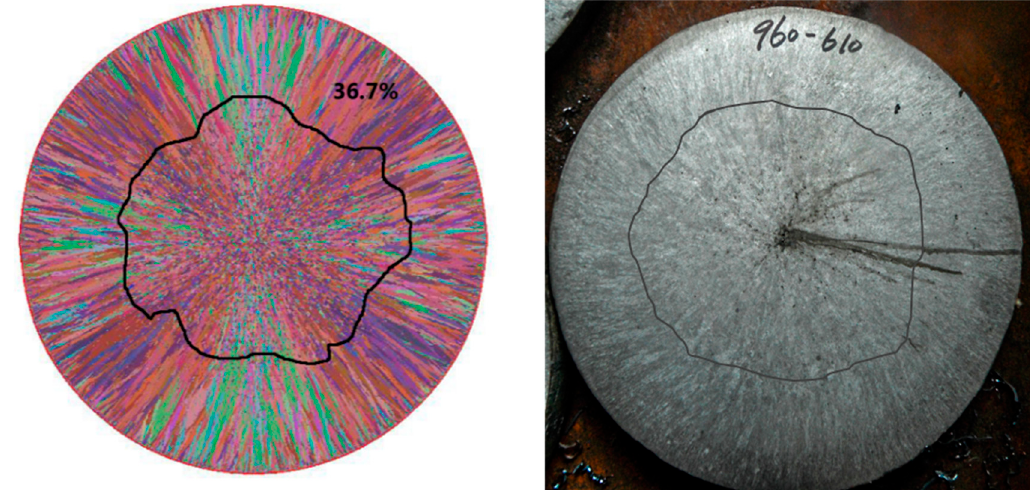
Figure 4. Simulation results and measured results of a continuous casting round billet, where the casting billet diameter is 178 mm on the left side.